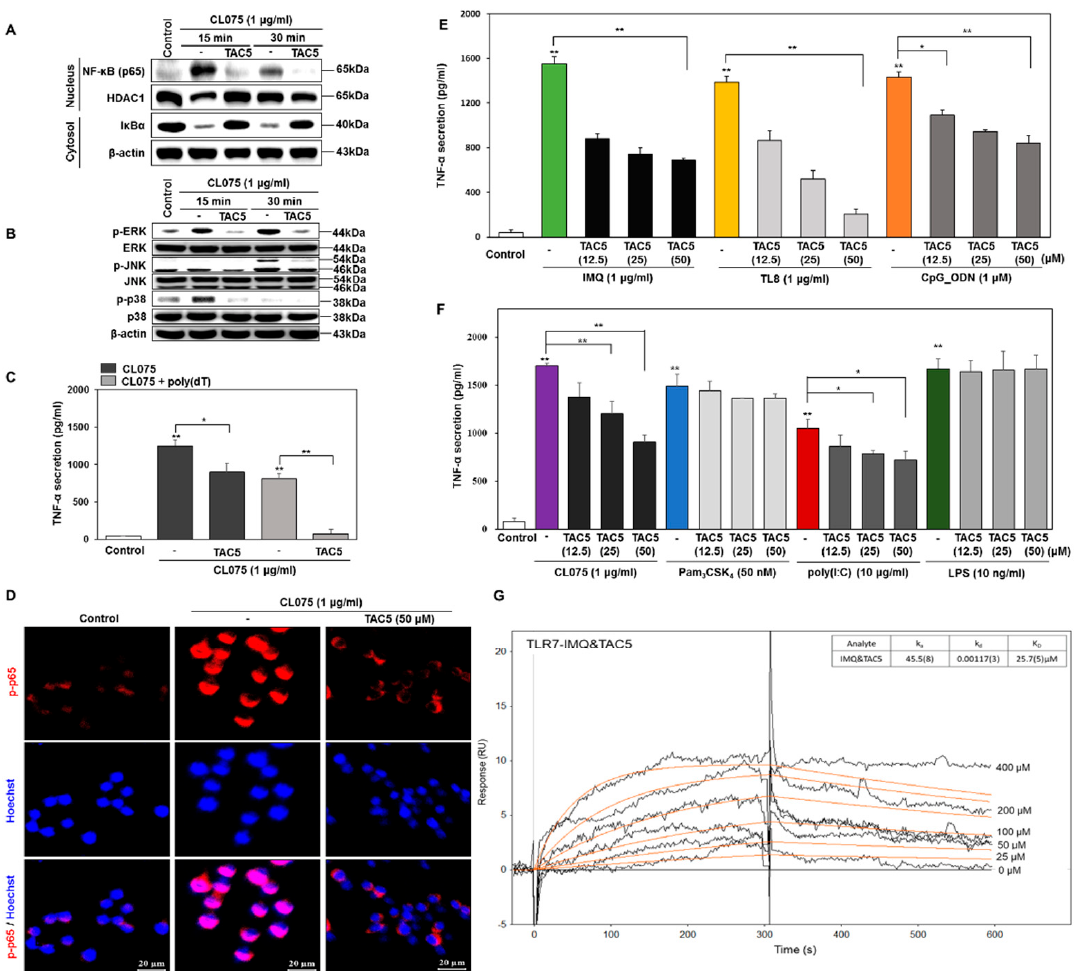
Figure 2. TAC5 inhibits the CL075-induced proinflammatory response. RAW 264.7 cells were treated with 50 µ M of TAC5 for 1 h, followed by treatment with CL075 (1 µ g / mL) for 15 and 30 min, respectively. ( A ) Nuclear factor kappa-light-chain-enhancer of activated B cells (NF- κ B) activation (NF- κ B translocation into the nucleus and degradation of I κ B α in the cytosol) was measured by western blotting. Histone deacetylase-1 was used as a nucleus loading control. β -actin was used as a cytosol loading control. ( B ) The expression levels of mitogen-activated protein kinases (MAPKs) were evaluated by western blot analysis using whole protein extracts, with inactive MAPKs used as controls ( β -actin was used as a loading control). ( C ) Inhibition of TNF- α secretion by TAC5 in the presence of CL075 and a combination of CL075 and poly(dT). ( D ) Confocal microscopy image of the phosphorylated NF- κ B (p-p65) expression level. The red staining corresponds to phosphorylated p65 subunit of NF- κ B (p-p65) and blue staining (Hoechst33258) indicates nuclei (the scale bar is 20 µm in width). ( E , F ) The expression level of TNF- α was measured by ELISA when the TAC5 was co-treated with ( E ) imiquimod (TLR7), TL8-506 (TLR8), CpG ODN (TLR9) (F) Pam 3 CSK 4 (TLR1/2), poly(I:C) (TLR3), LPS (TLR4), or CL075 (TLR7/8) agonists in RAW 264.7 cells. ( G ) Surface plasmon resonance (SPR) sensorgram illustrating the competitive binding of TAC5 to TLR7 in the presence of imiquimod. The data shown represent five independent experiments, and the bars represent means ± SEM (* p < 0.05, ** p < 0.01)..